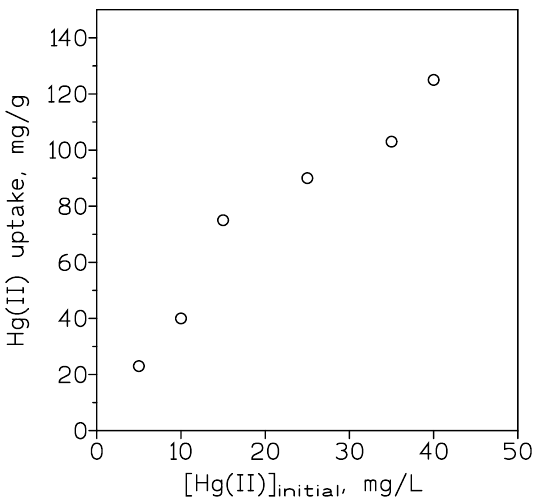
Figure 4. Variation of Hg(II) uptake at various initial Hg(II) concentrations in the aqueous solution. Time: 13.5 h. Results derived from the fit of experimental results to the pseudo-second order kinetic